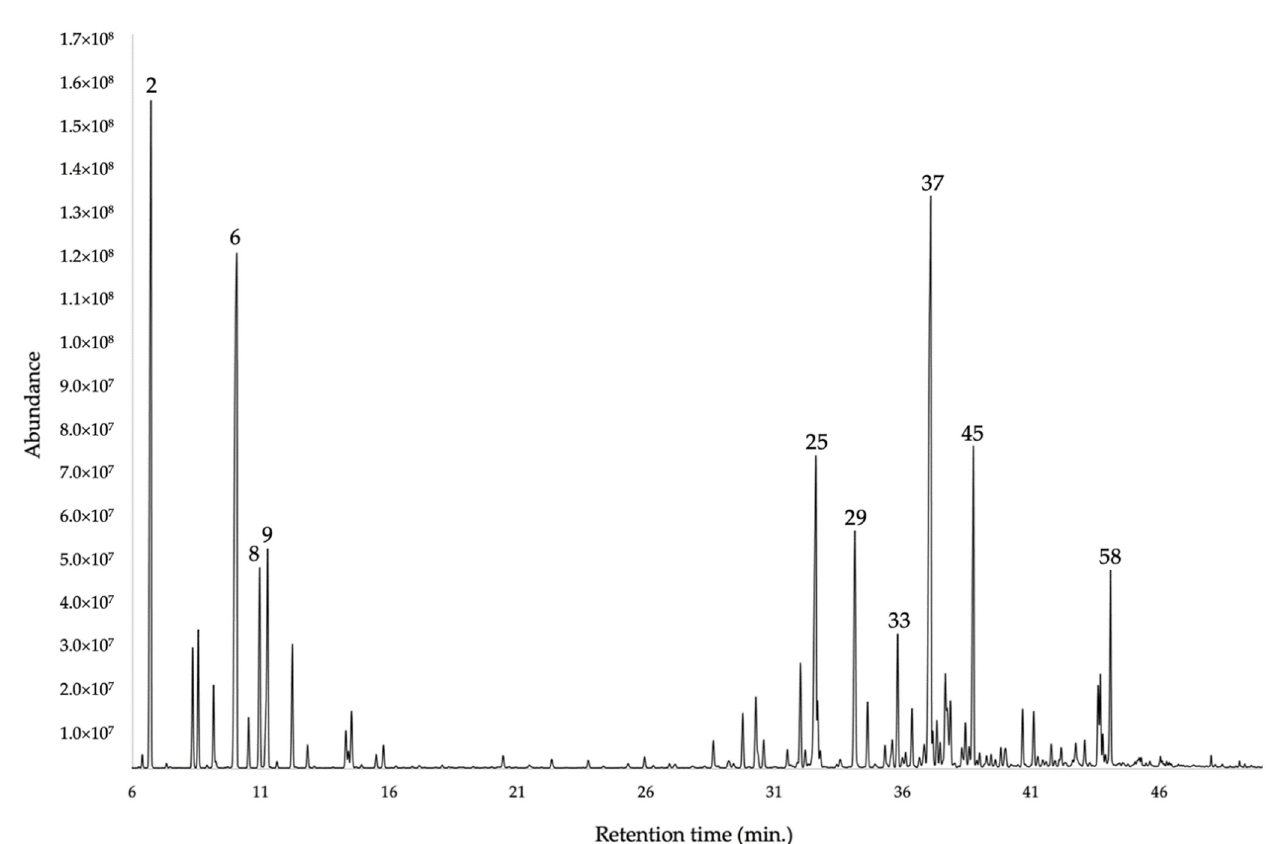
Figure 1. GC-MS chromatogram of G. miniphylla EO obtained with a 5%-phenyl-methylpolysiloxane capillary column. The numbers correspond to the main components ( ≥ 2% with at least one column).